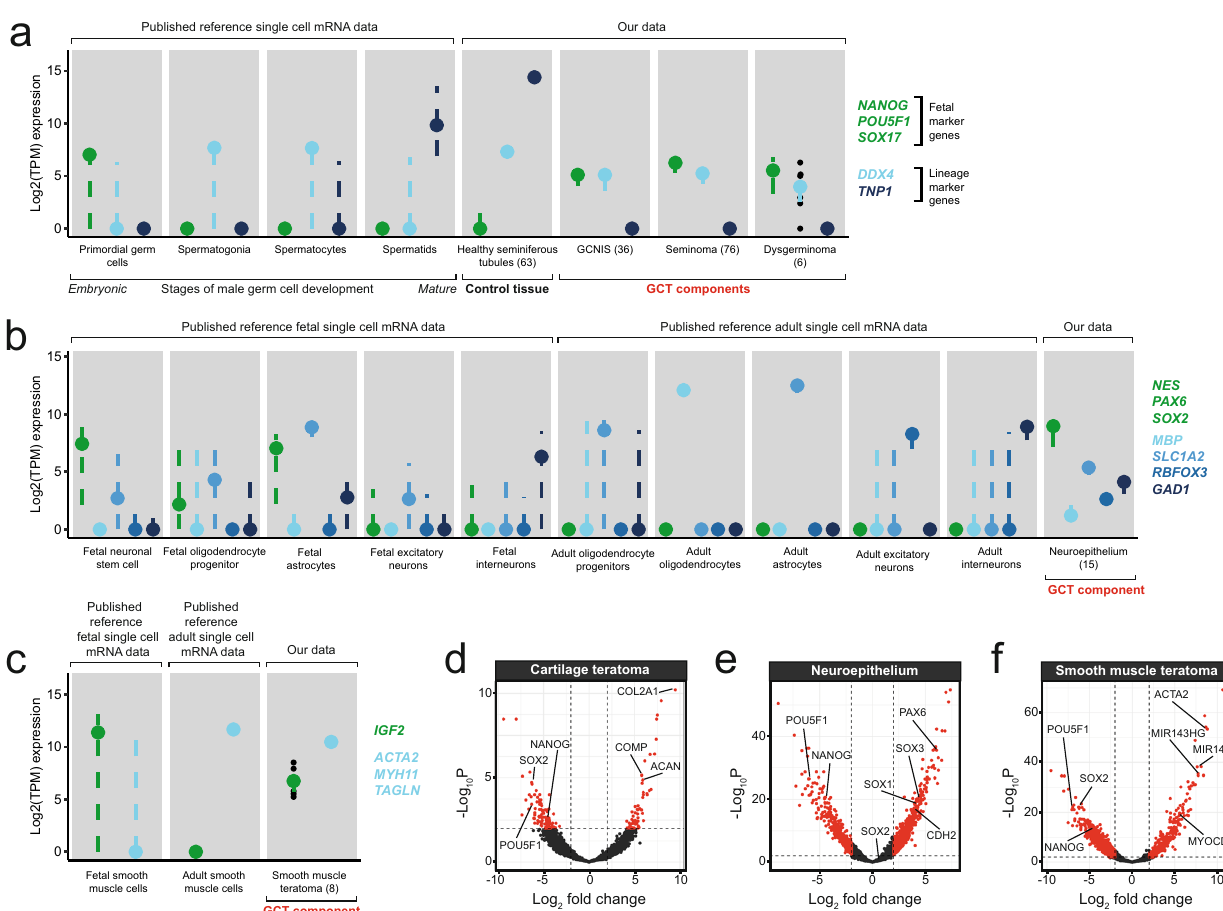
Fig. 3 Pathways of GCT histogenesis. a – c Comparison of the expression of marker genes in example GCT tissues and their corresponding fetal and adult counterparts, using reference single cell datasets 19 – 23 . Coloured dots denote the median and dashed lines the interquartile range for the underlying data points which represent the expression of a single gene per microbiopsy per tissue. Individual data points are plotted where the total data points supporting a point range are ≤ 10. The total number of microbiopsies supporting the data in each grey panel is provided in brackets within the fi gure. Source data are deposited on Mendeley. d – f Example volcano plots illustrating the differential expression analysis between embryonal carcinoma and more mature GCT tissues. The dashed lines represent the cut-offs for the log2 fold-change (>|2 | ) and adjusted p -value (<0.01, Benjamini-Hochberg correction) considered signi fi cant. Genes enriched in each differentiated tissue are shifted to the right. Marker genes used to de fi ne embryonic stem cells and each differentiated tissue are annotated on the plot. The full list of genes and tissues comparisons can be found in Supplementary Data